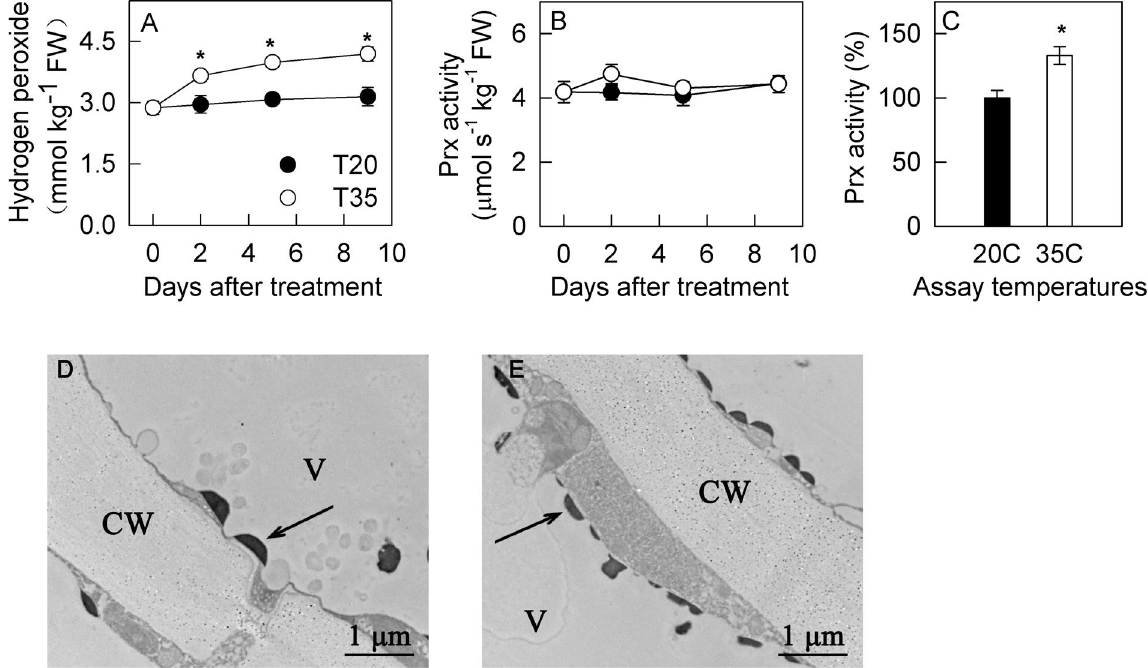
Figure 5. Hydrogen peroxide concentration and class III peroxidase (Prx) activity in the peel of plum fruits treated at 20 °C and 35 °C for different time in the dark. Panel A, hydrogen peroxide concentration in the peels during treatments; Panel B, Prx activity in fruit peels assayed at 20 °C; Panel C, Prx activity in 35 °C treated fruit for 9 days assayed at 20 °C and 35 °C; Panel D and E, cytochemical localization of hydrogen peroxide and Prx activity. Sections were incubated with CeCl 3 , and the electron-dense deposits represent of both Prx activity and produced hydrogen peroxide in the inner part of the tonoplast, marked with arrows. The vacuolar region is marked with “V”. Bar, 1 μ m. Each data point represents mean ± SE (n = 5) in Panel A–C. The asterisk indicates a significant difference between two temperature treatments at P < 0.05, t